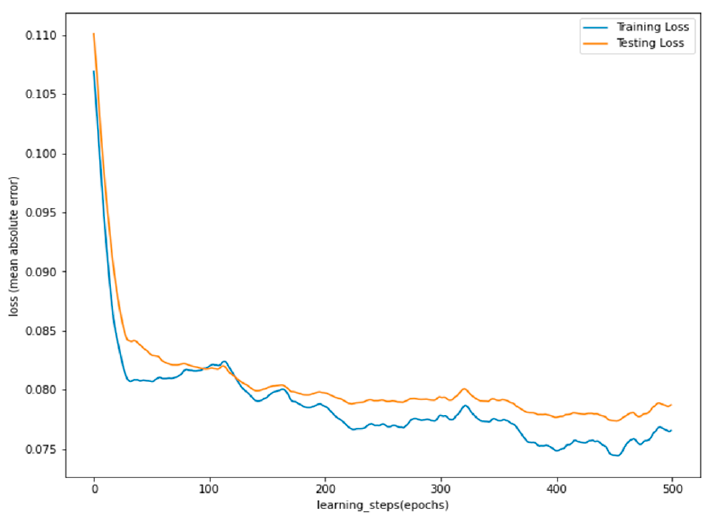
Figure 3. The outcome of the Learning curve.